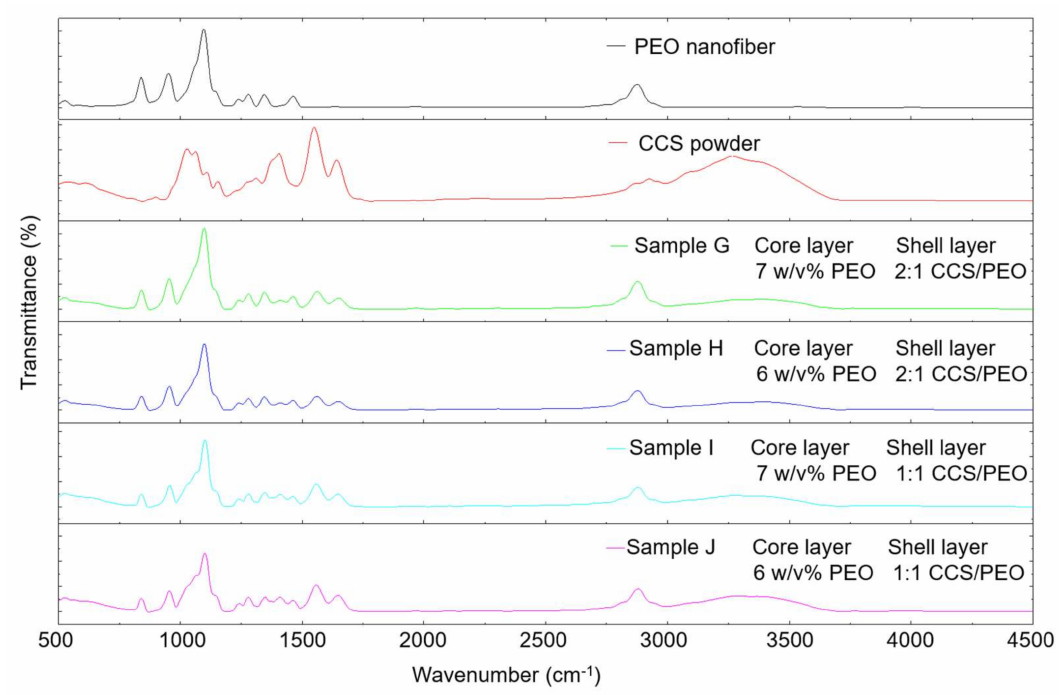
Figure 7. FTIR spectra of the pure PEO, pure CCS, and composite nanofibers via co-axial centrifugal spinning.